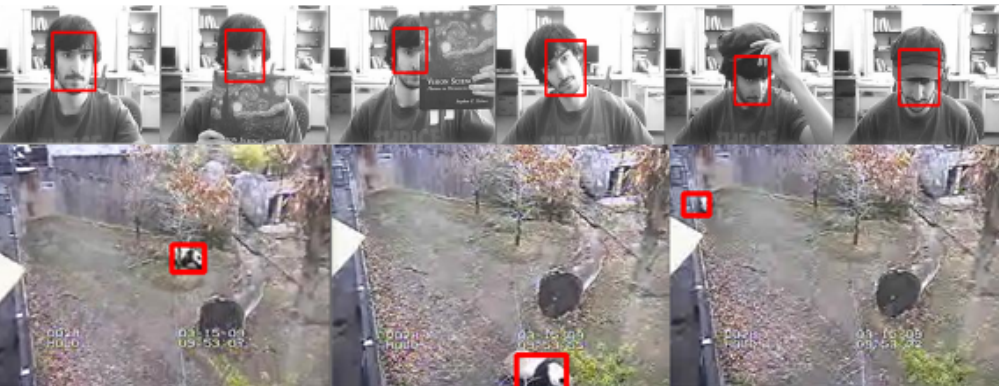
Figure 9. Several challenging video sequences in OTB-2015 involving incomplete targets. From top to bottom, the pictures are FaceOcc2 and Panda. The attributes are OCC and OV. In these two scenarios, despite the appearance and shape of the target being incomplete, the tracking recognition effect is good, and there is no significant drift or tracking failure.